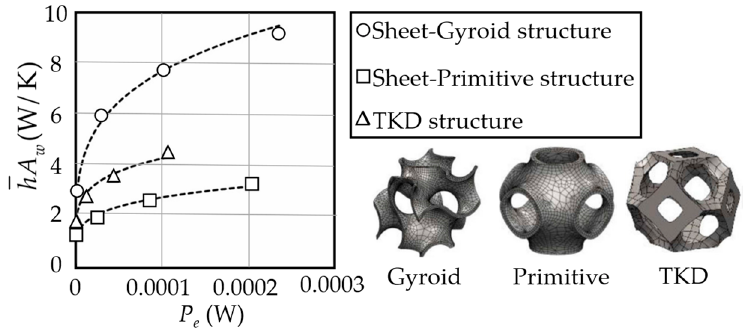
Figure 22. Net heat dissipation capability of each topology [47].